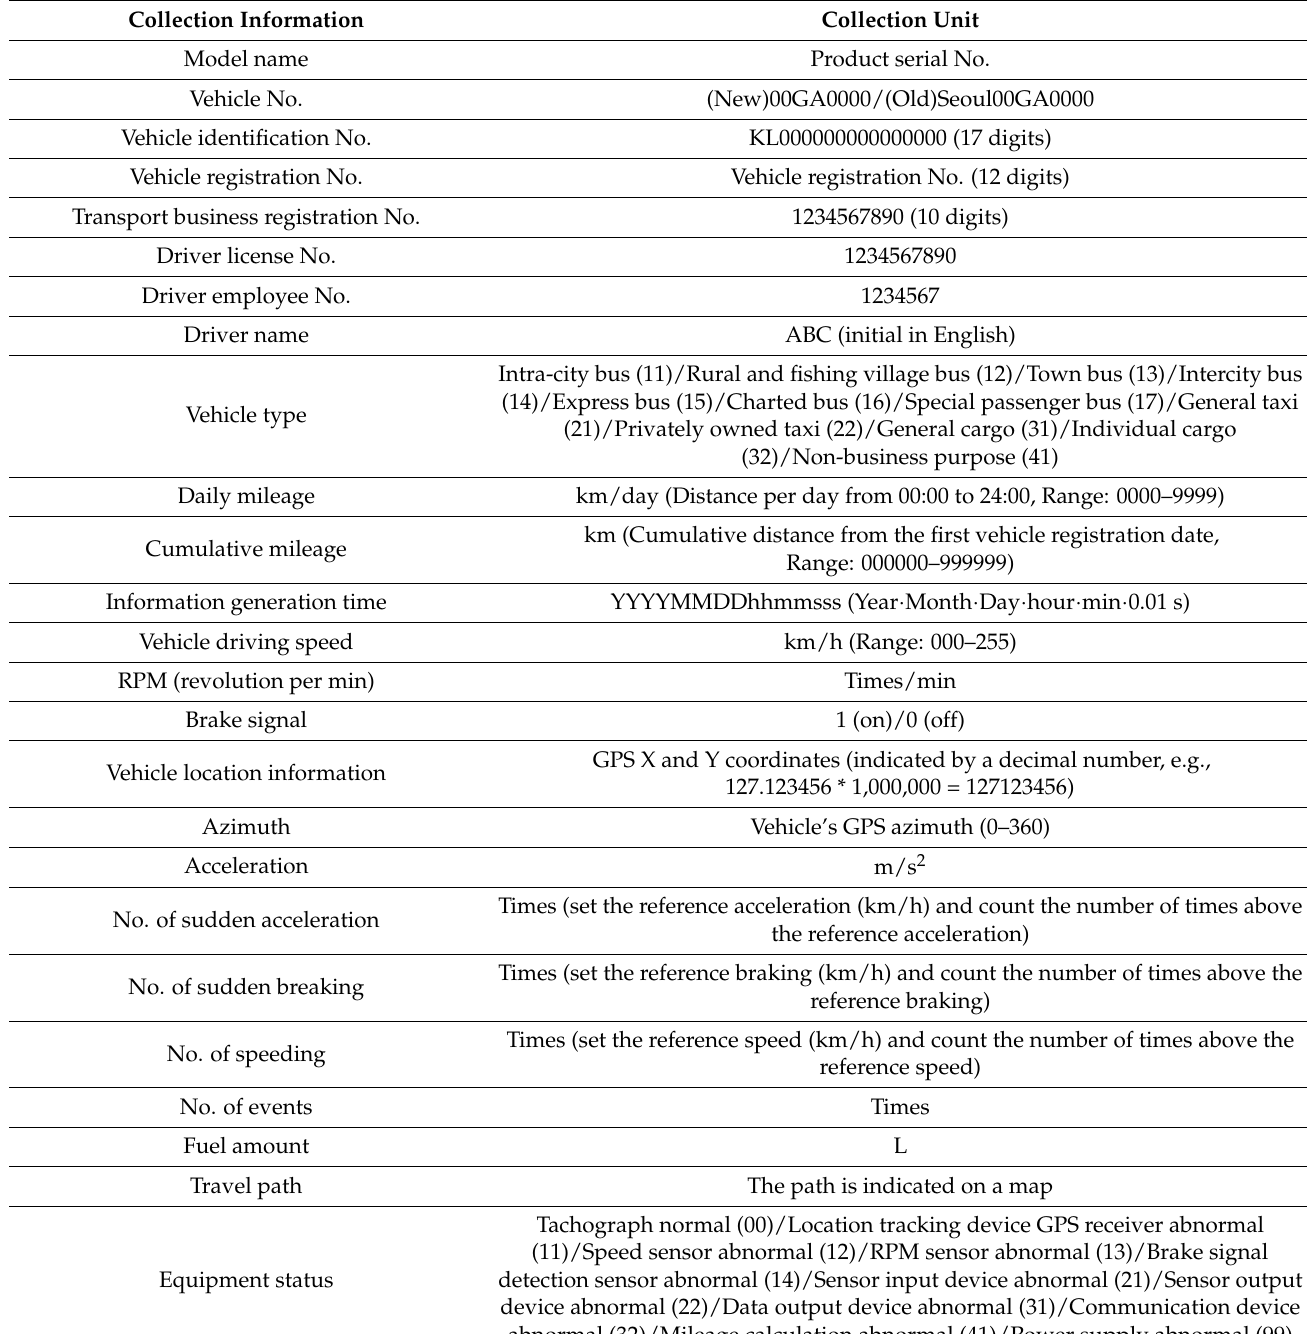
Table 3. DTG data collection information and unit